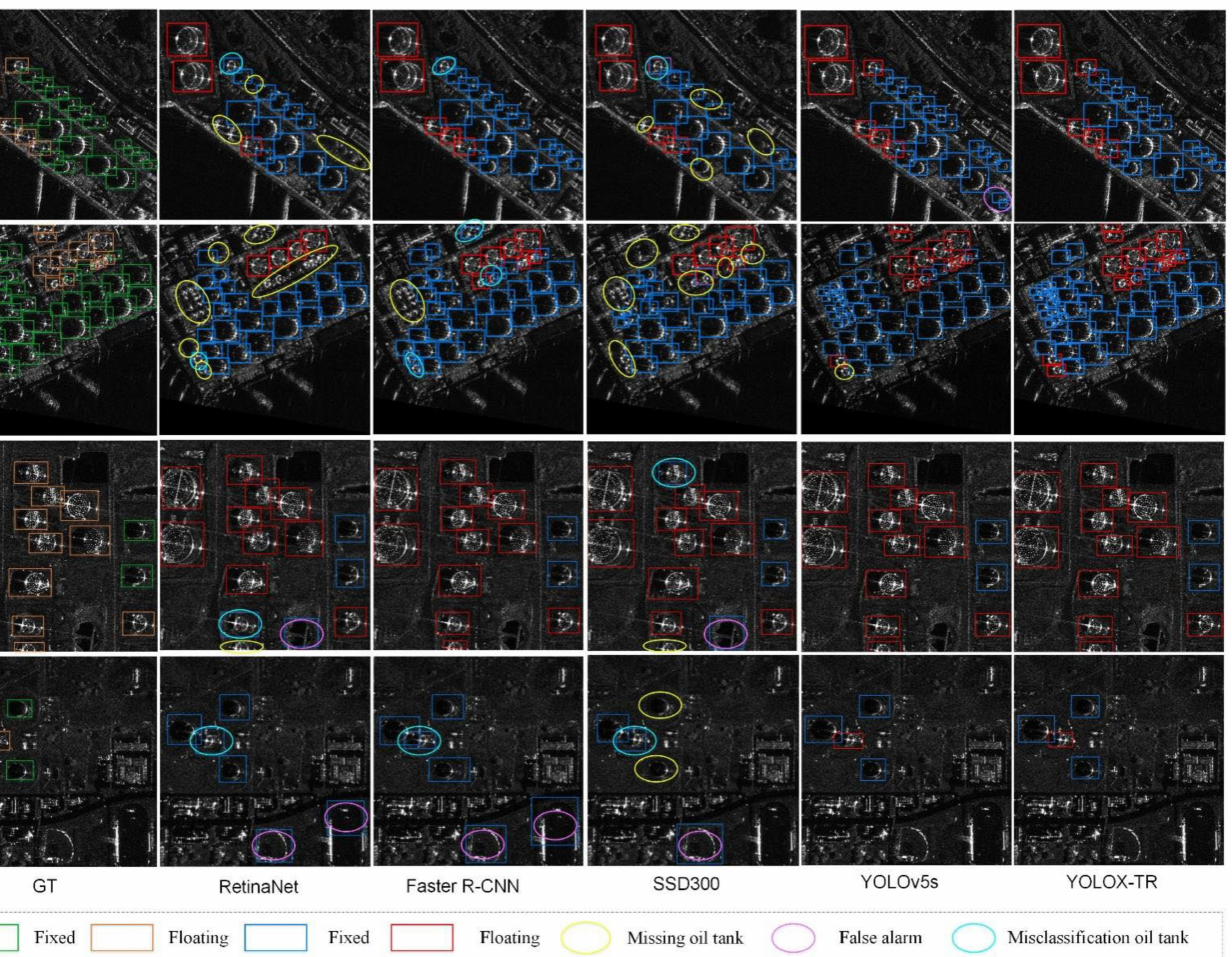
Figure 10. The visual detection result of the comparison experiments of RetinaNet, Faster RCNN, SSD, YOLOv5, and